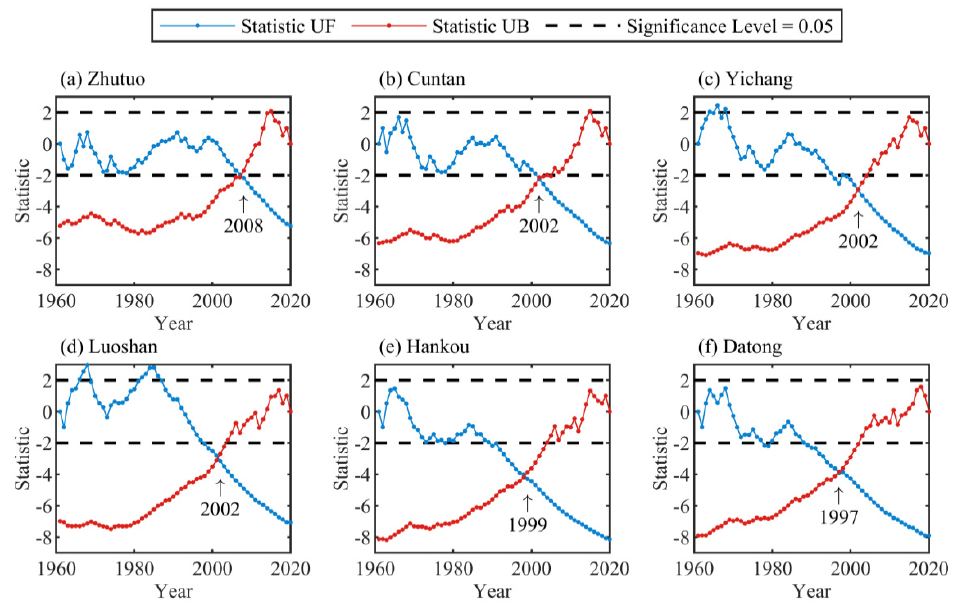
Figure 3. Abrupt analysis of the sediment load at six hydrological stations in the Yangtze River.